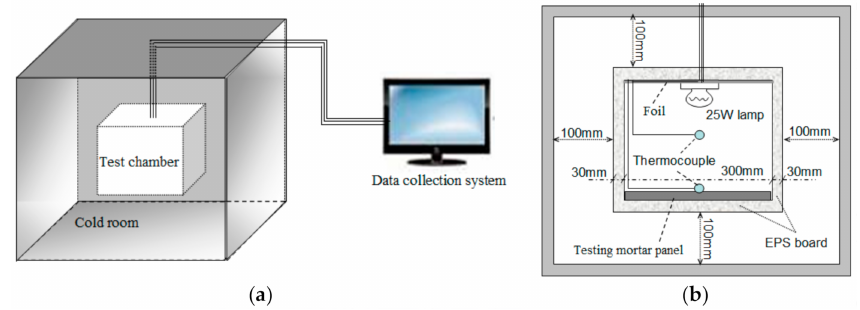
Figure 8. Schematic of the experimental device: ( a ) overall schematic, ( b ) cross-sectional view. ◦ After curing for 28 days and then drying at 50 C to a constant weight, three panel specimens (300 × 300 × 30 mm) with SSPCM mass fraction of 0%, 30%, and 50% were tested, respectively. The test chamber was a cube box model composed of six 300 × 300 × 30 mm expanded polystyrene (EPS) panels. In the chamber, a SCTESM test panel was placed on the bottom and a 25 W iodine-tungsten filament lamp was fixed at the top center as a heat source during heating. The thermocouples were fixed at the center of the chamber and at the interior surface of the specimen panel. During the test,